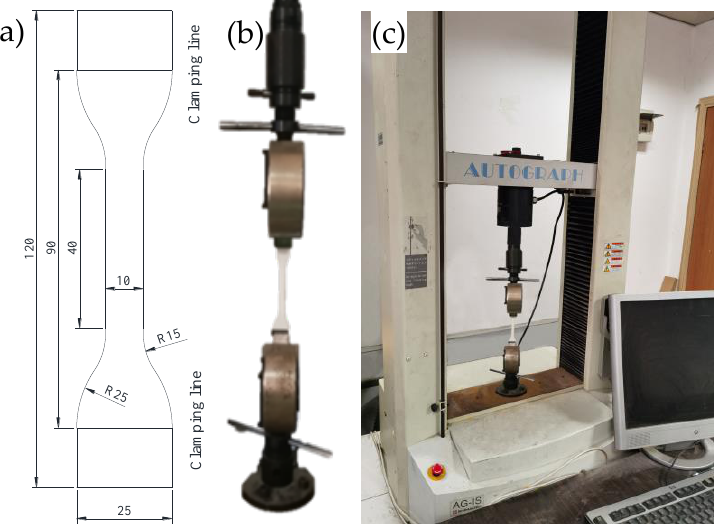
Figure 1. Uniaxial tension test process: ( a ) uniaxial tension sample size/mm, ( b ) clamping of specimens, and ( c ) test machine loading.